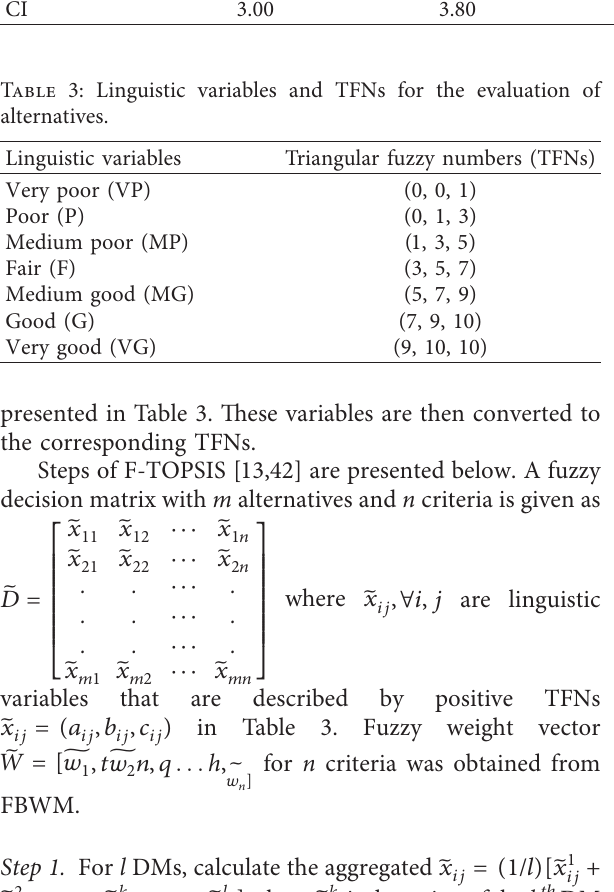
Step 4. Define the fuzzy positive-ideal solution ( A ∗ ) and